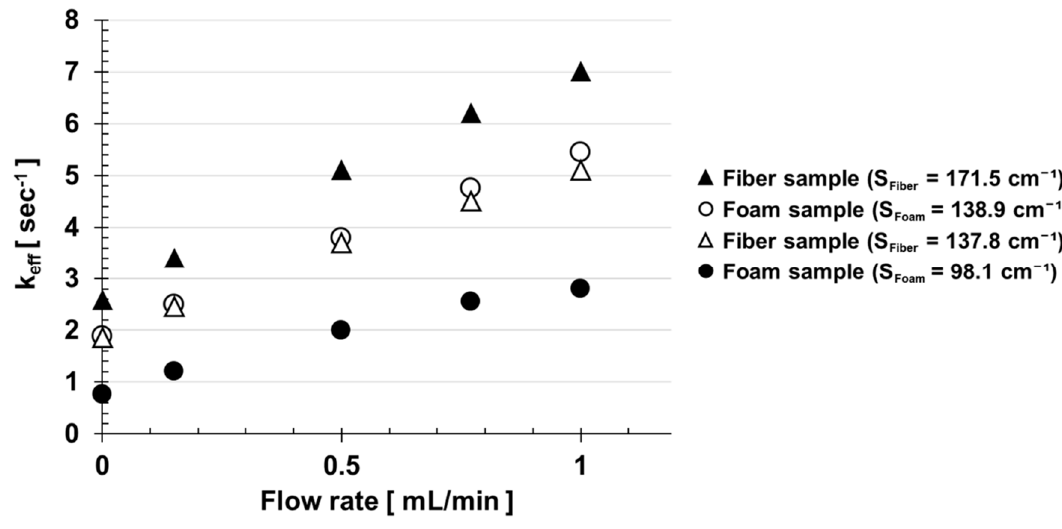
Figure 6. E ff ective O 2 reaction coe ffi cient k e ff as a function of perfusion flow rate and sca ff old Figure 6. Effective O 2 reaction coefficient k eff as a function of perfusion flow rate and scaffold architecture. Data is plotted for the limiting case of the fully reactive rLST architecture. Data is plotted for the limiting case of the fully reactive rLST particles.